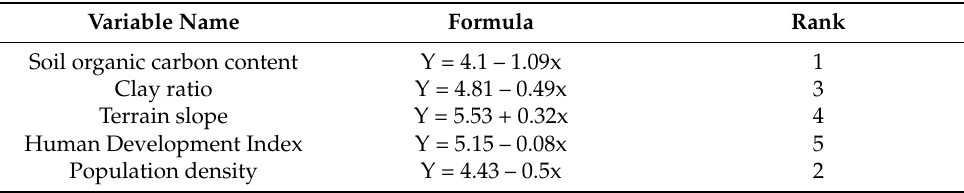
Table 4. Results of the sensitivity analysis of the selected soil ‐ erosion model.